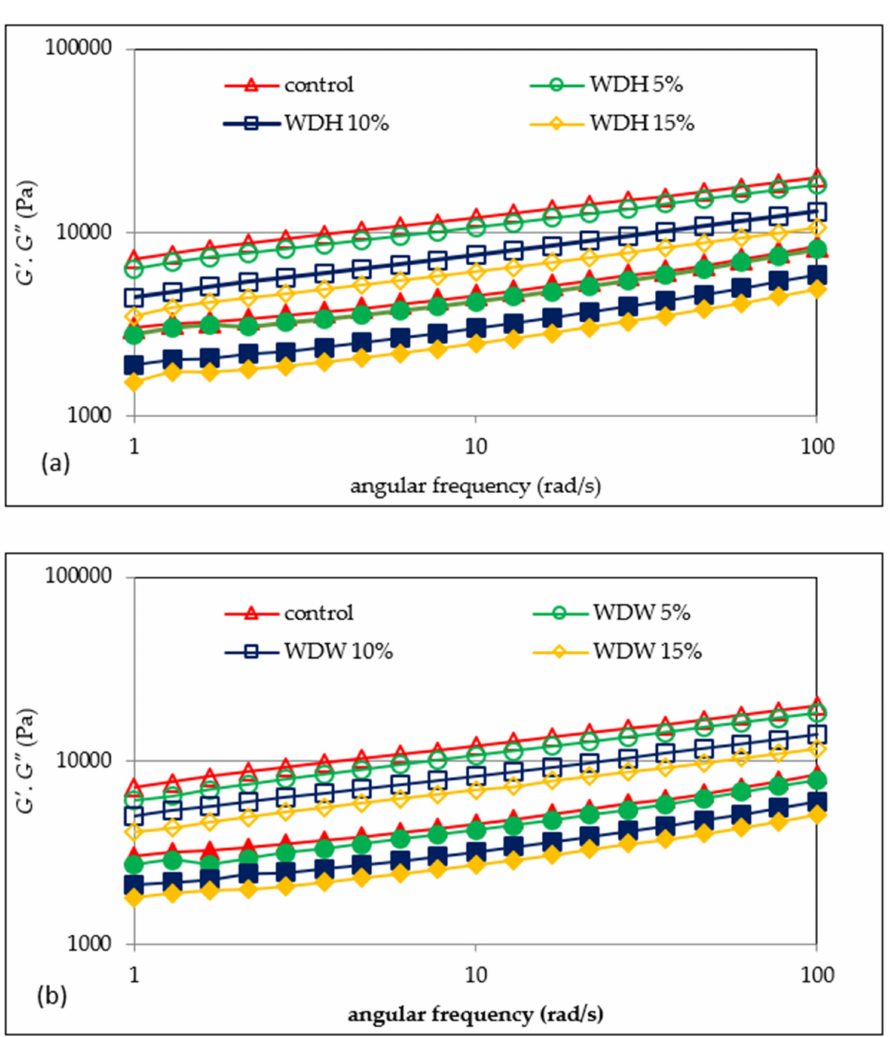
Figure 2. Mechanical spectra of doughs with the addition of hazelnut ( a ) or walnut ( b ) flour. G (cid:48) denotes an empty marker; G (cid:48)(cid:48) denotes a filled